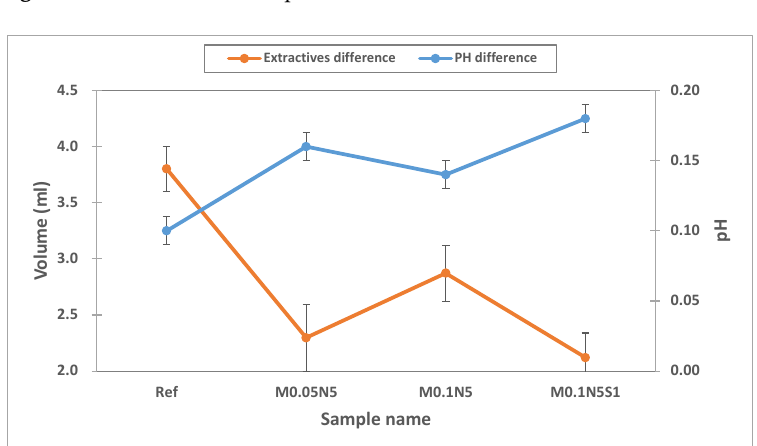
Figure 7. Absorbance of samples.